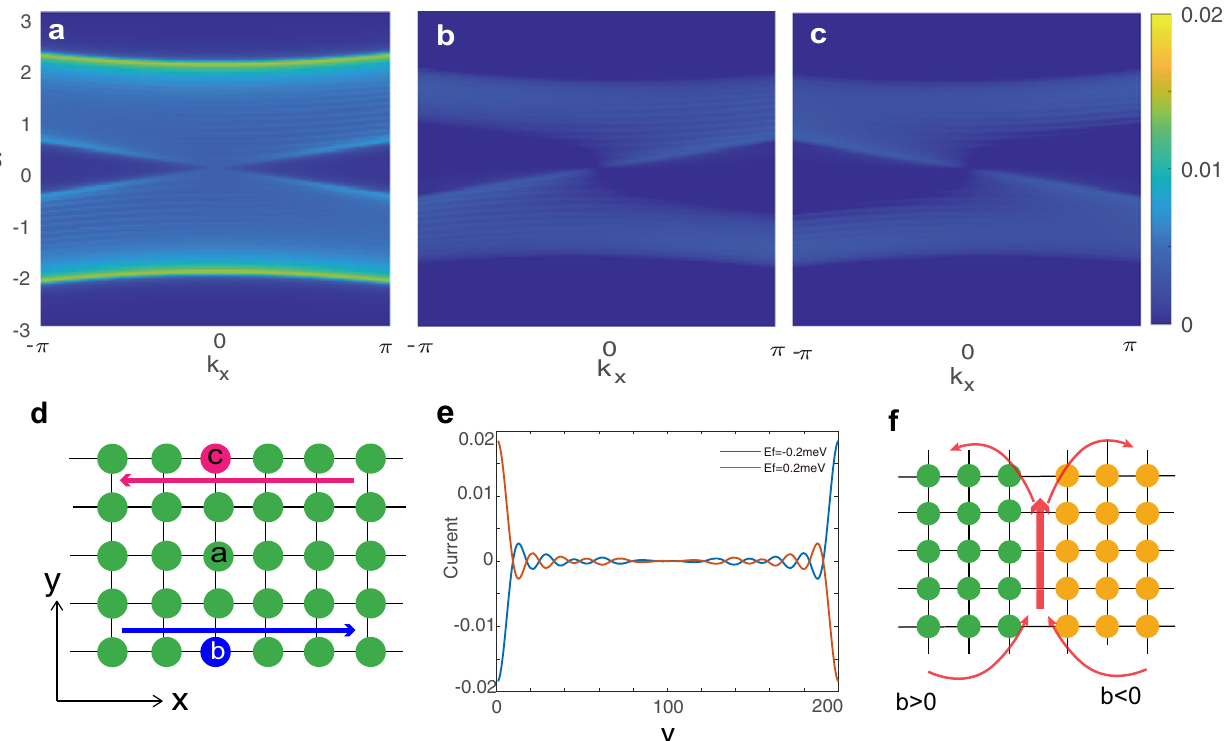
Fig. 3 The local density of states and edge current distribution in the absence of external fi eld. a The local density of states at the middle of the sample. b The relative local density of states at the top edge (pink dot) ρ r ( k x , y = L y ). c The relative local density of states at the bottom edge (blue dot) ρ r ( k x , y = 1). The relative local density of states means that the contribution from bulk is already deducted, = ρ ( k − ρ ( k ρ = ρ ( k − ρ ( k ρ r ( k x , 1) x , 1) x , L y /2) and r ( k x , L y ) x , L y ) x , L y /2). d A schematic of a stripe sample with the labelled positions for ( a , b , and c ). e The current density distribution for two different Fermi levels slight deviating from the half fi lling. f The Hall and longitudinal currents along the domain wall in two dimensions. Here L y = 200, v = 1 and b 0 =